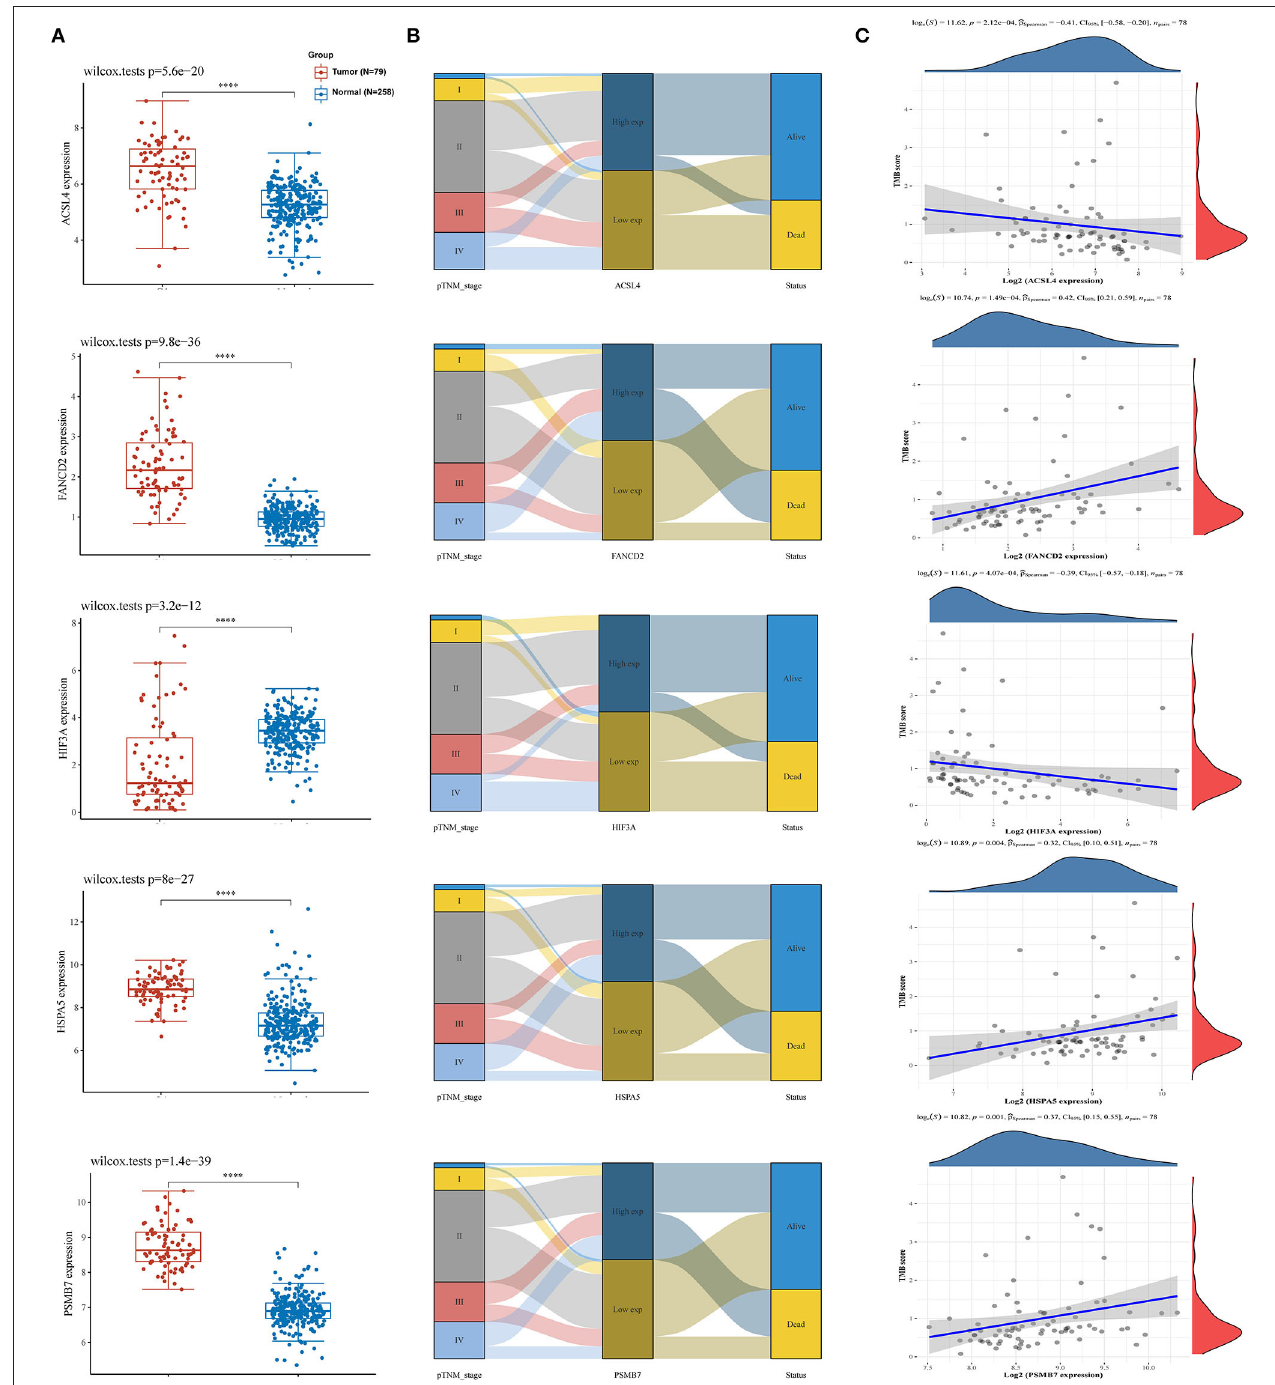
FIGURE 6 | The interaction of five hub genes in the predictive model and TMB. (A) The expression distribution of 5 genes in ACC and normal tissues; (B) Sankey diagram of pTNM stage, gene expression and survival status; (C) Correlation analysis of gene expression and TMB. TMB, tumor mutation burden; ACC, adrenocortical carcinoma; pTNM stage, pathology Tumor Node Metastasis stage. *: P < 0.05; **: P < 0.01; ***: P < 0.001.